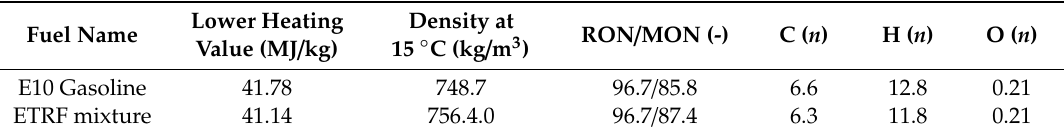
Table 7. Liquid properties of the experimental and surrogate fuel mixture used in the SI engine simulation campaign.